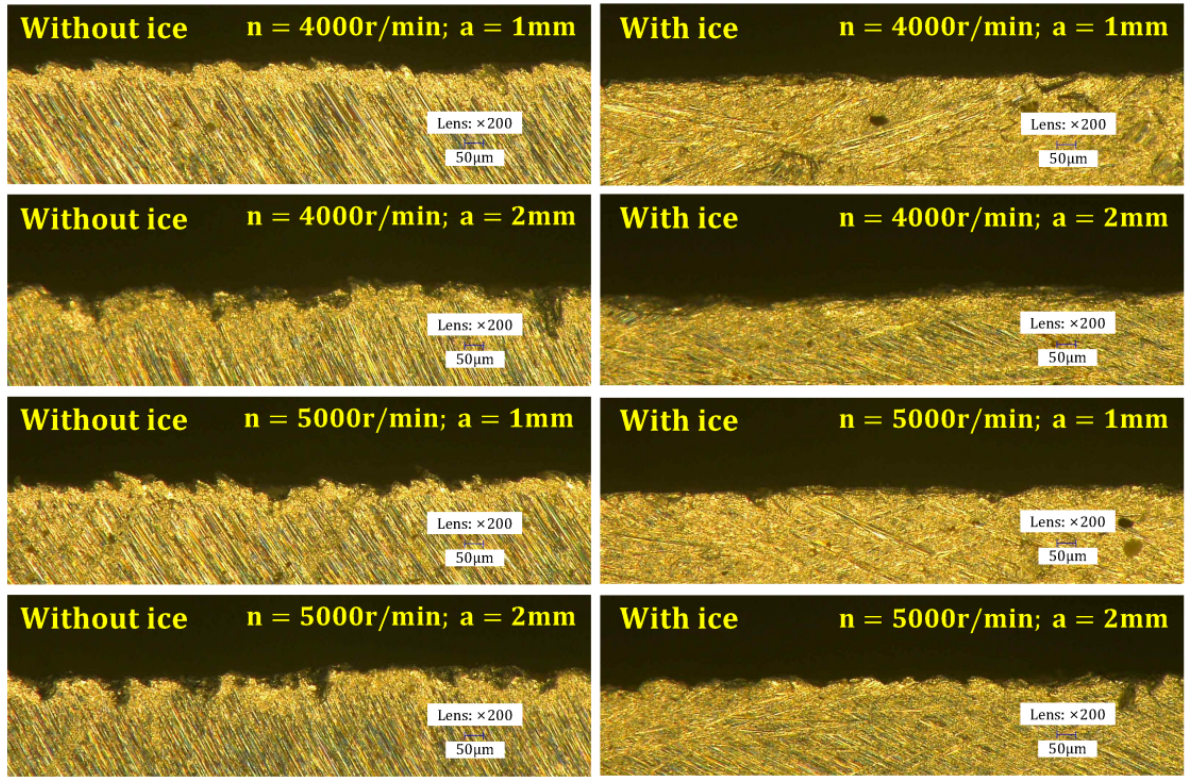
Figure 8. Workpiece edge topography.